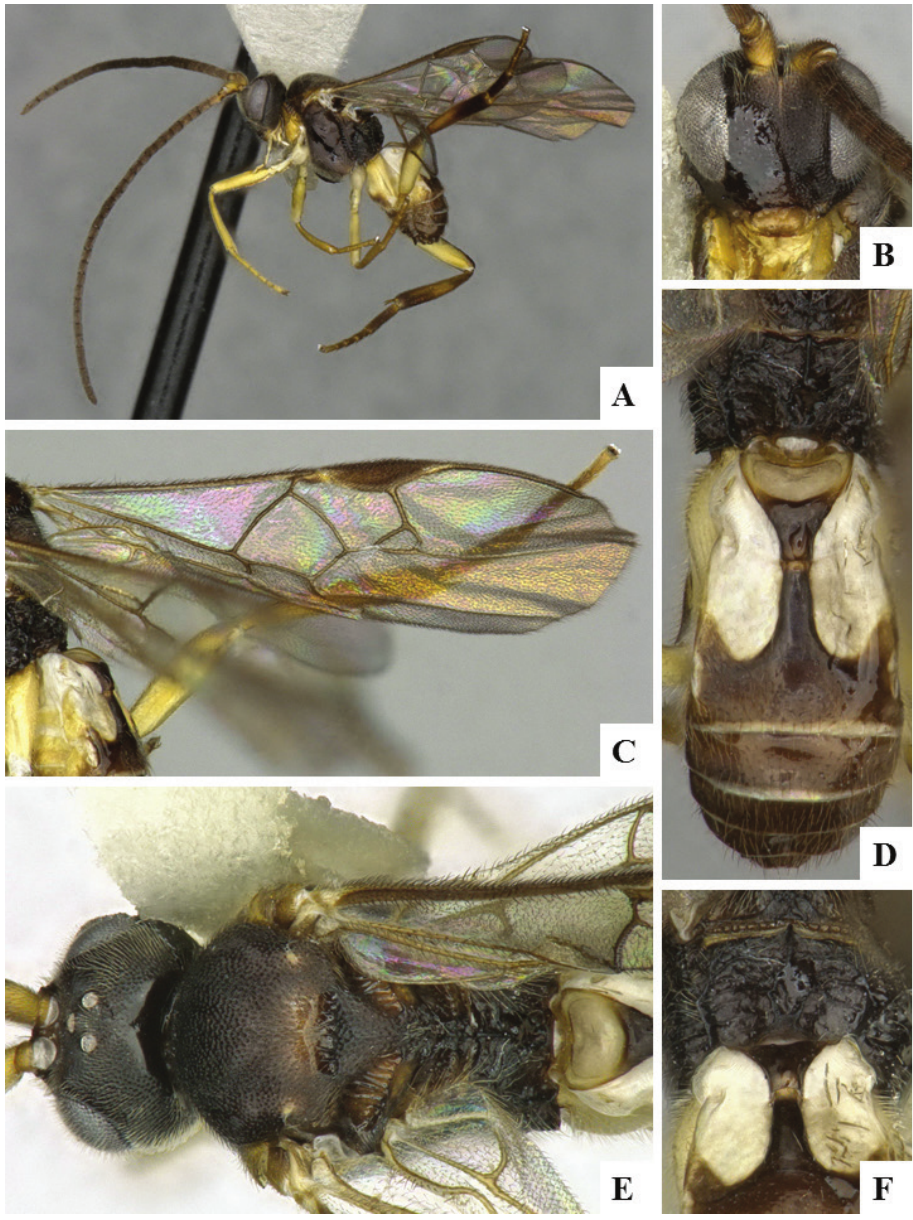
Figure 37. Tobleronius orientalis male paratype CNC521929. A Habitus B Head frontal C Fore wing D Metasoma dorsal E Head and mesosoma, dorsal F